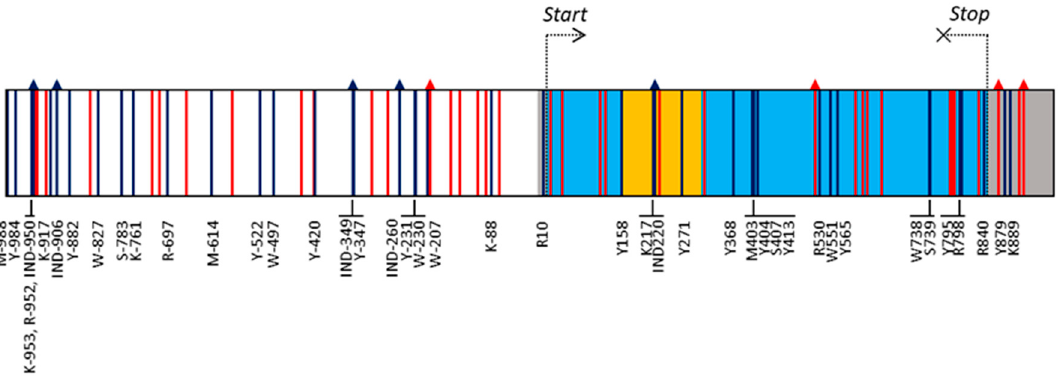
Figure 1. Gene structure and polymorphisms detected in the VviUCC1 gene sequence. Boxes indicate promoter (white), 5 (cid:48) - and 3 (cid:48) -UTRs (grey), exons (light blue), and intron (yellow). SNPs and INDELs are indicated as vertical lines and vertical arrows, respectively. Their color indicates the frequency of the minor allele (MAF): red < 0.05; dark blue > 0.05. For simplicity, only the name of those polymorphisms with a MAF > 0.05 is shown (the whole list can be found in Table